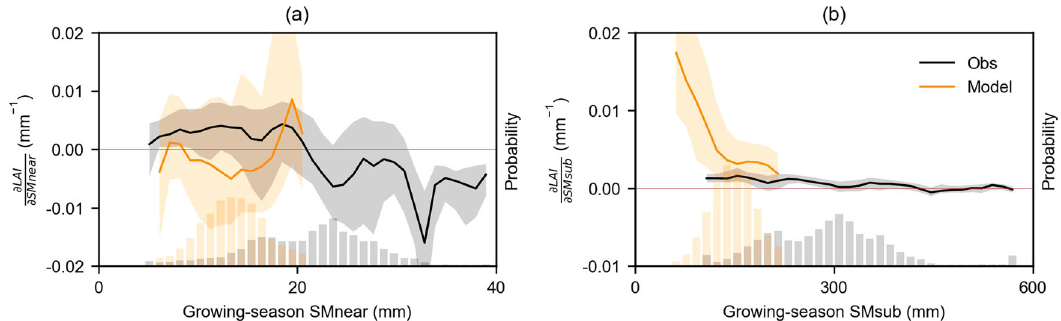
Fig. 2 Response functions of global LAI sensitivity to soil moisture. a Response functions of LAI sensitivity ( ∂ LAI ∂ SMnear ) to growing-season mean near-surface soil moisture (growing-season mean SMnear) from observations (Obs) and land surface models (Model). b Similar to a but for LAI sensitivity to sub- surface soil moisture ( ∂ LAI ∂ SMsub ). In a , b , global grid cells with signi fi cant LAI sensitivities to soil moisture are included. Two-sided signi fi cance tests are done for each grid cell at the p < 0.01 level as assessed with Theil-sen regressions. The solid line and shaded areas show the median and interquartile ranges of LAI sensitivity. Probability distributions of near-surface soil moisture in observations and models are shown at the bottom of each plot. Results here are based on ensemble-product means, while results from individual products or models are presented in Supplementary Fig. 4.